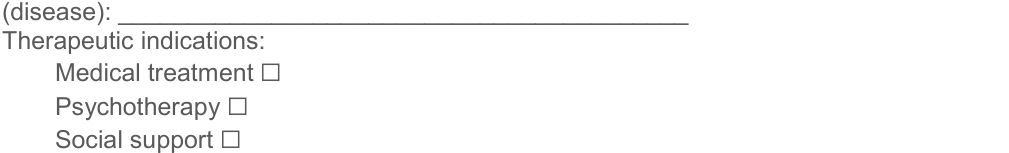
Figure 1 . Reproduction of TEFs’ presentation